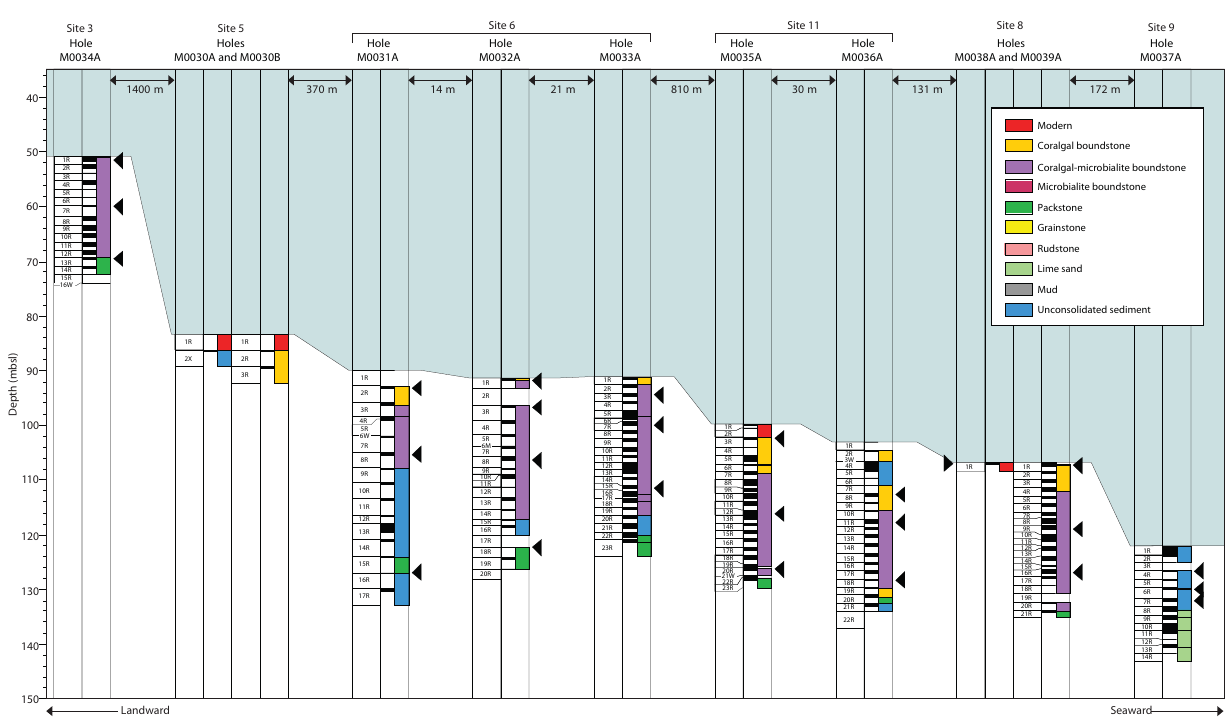
Figure 4. Lithostratigraphic summary of holes on the Transect HYD-02 (Sites from landward to seaward; M0034A, M0030A, M0030B, M0031A, M0032A, M0033A, M0035A, M0036A, M0038A, M0039A, and